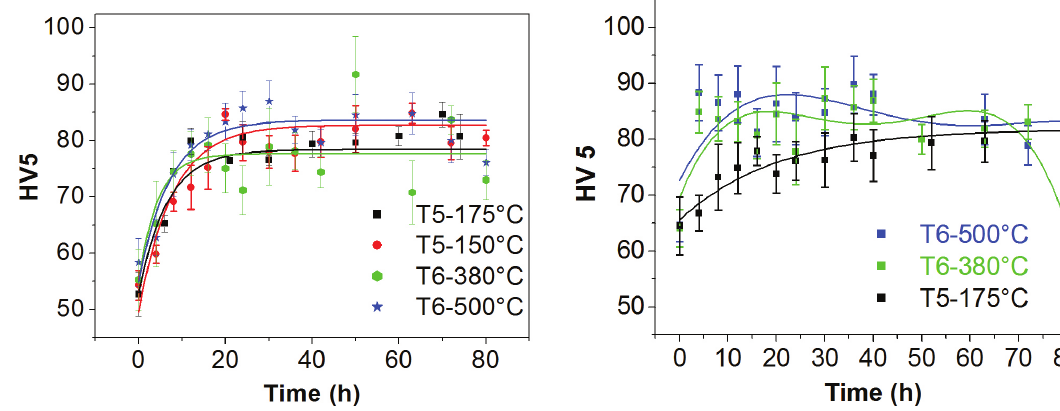
Figure 4. Hardness (HV5) as a function of heat treatment time for the ZK60-2.5wt.%RE alloy submitted to ageing treatment at various temperatures.